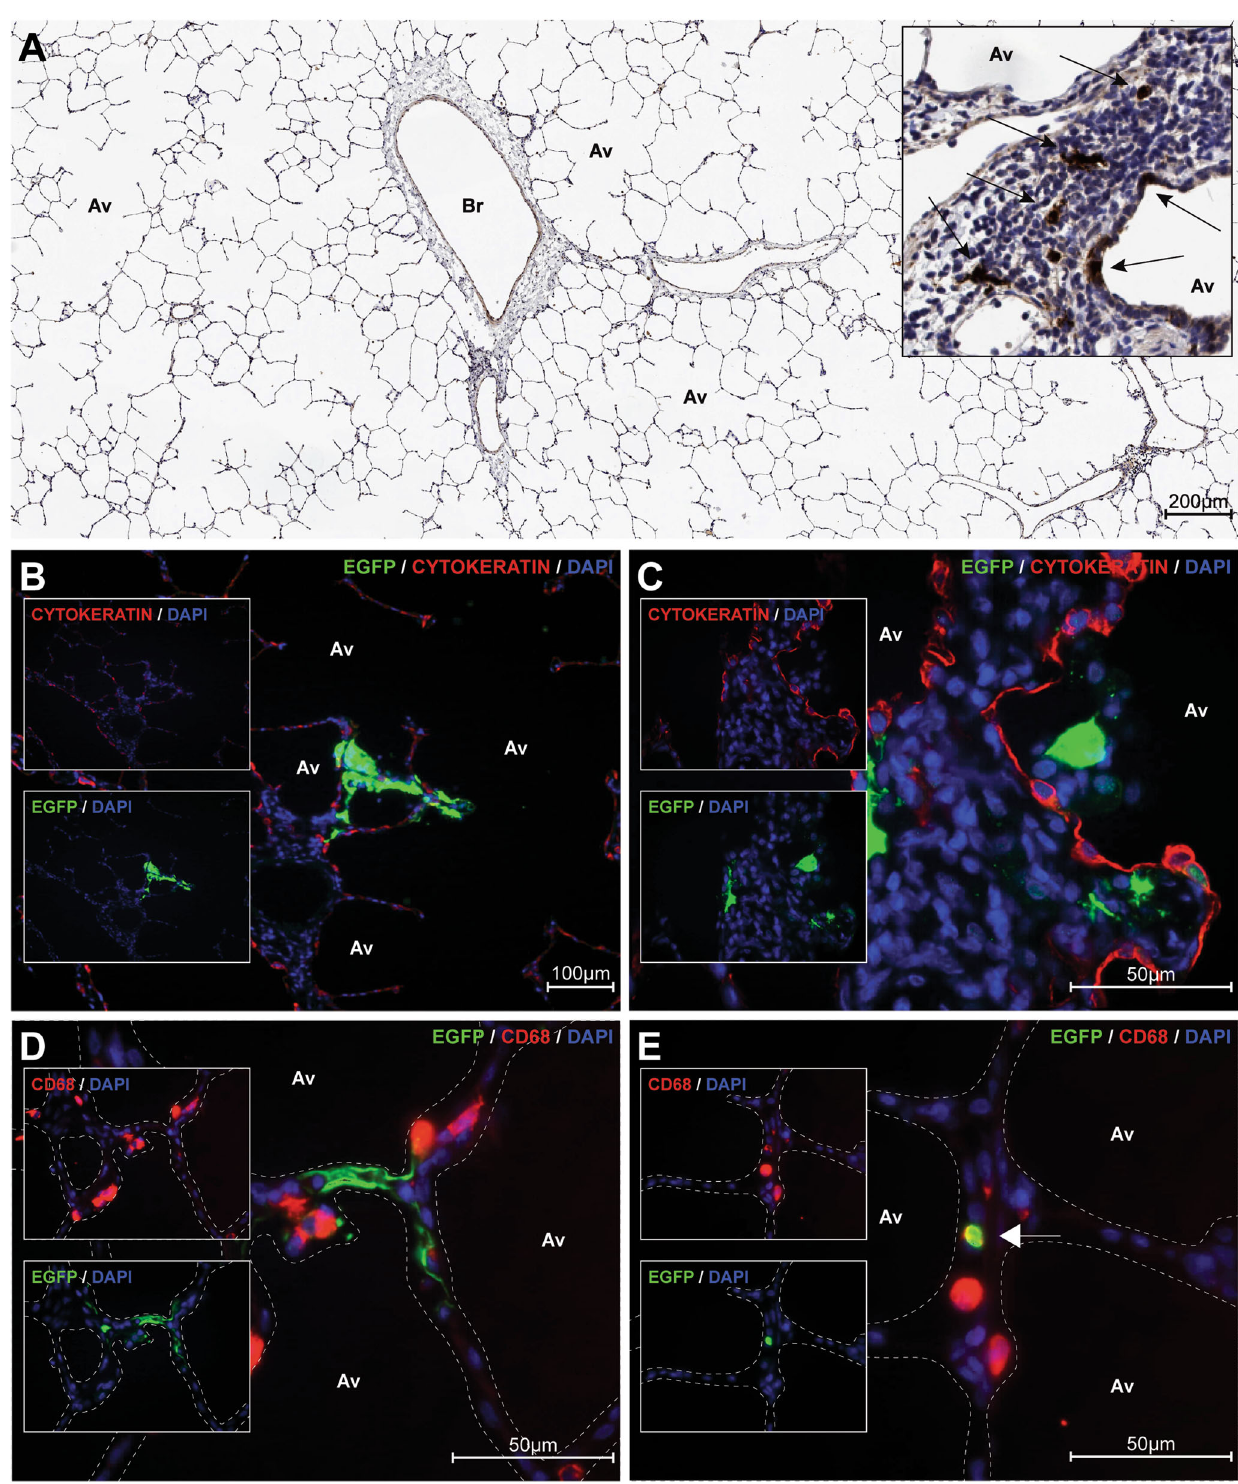
Fig. 3 Tropism. Macaques were euthanized by exsanguination 3, 5, or 7 DPV. During necropsy, lungs were in fl ated with low-melting point agarose and allowed to solidify on ice. Lung slices were screened by UV microscopy for the presence of EGFP-positive cells. Seven micrometer sections were prepared from leveled, fi xed, and paraf fi n embedded tissues to permit small numbers of EGFP-positive cells to be identi fi ed. a Hematoxylin counterstained anti-EGFP immunohistochemical staining of a lung slice, showing evidence of EGFP-positive cells in brown (see inset , positive cells indicated by arrows); b , c EGFP ( green )/4 ’ ,6-diamidino-2-phenylindole ( DAPI ; blue ) / cytokeratin ( red ) staining (single fl uorescence scans shown in insets ); d , e : EGFP ( green )/DAPI ( blue )/CD68 ( red ) staining (single fl uorescence scans shown in insets ). Arrow in panel e indicates CD68 and EGFP co-localization. Images shown were collected from animal T-41 (see Table S1, group 4 A (AI), euthanized 5 DPV). Av alveoli, Br